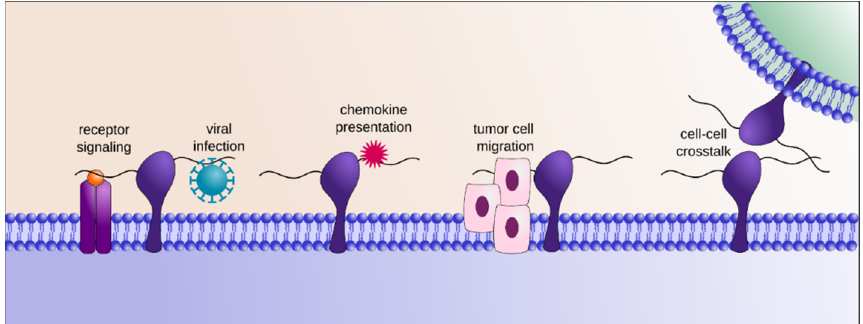
Figure 1. Heparan sulfate proteoglycans (HSPGs) contribute to the formation of the glycocalyx at the cell surface and are ubiquitously present in the extracellular matrix, where they interact with a myriad of different HS binding proteins. In doing so, they integrate the flow of information that circulates in-between cells and upstream signaling that is mediated by the cytokines/growth factors-receptor interaction. They are also further involved in chemokines/morphogens gradient stabilization and presentation, cell migration and adhesion or microbial adsorption, thereby regulating many fundamental biological processes.